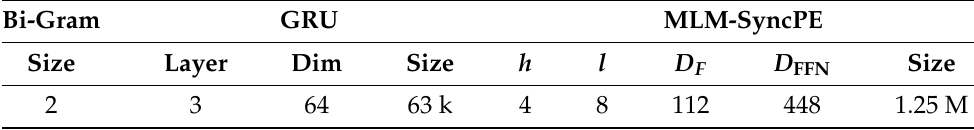
Table 2. Hyperparameters of the three language models optimized by